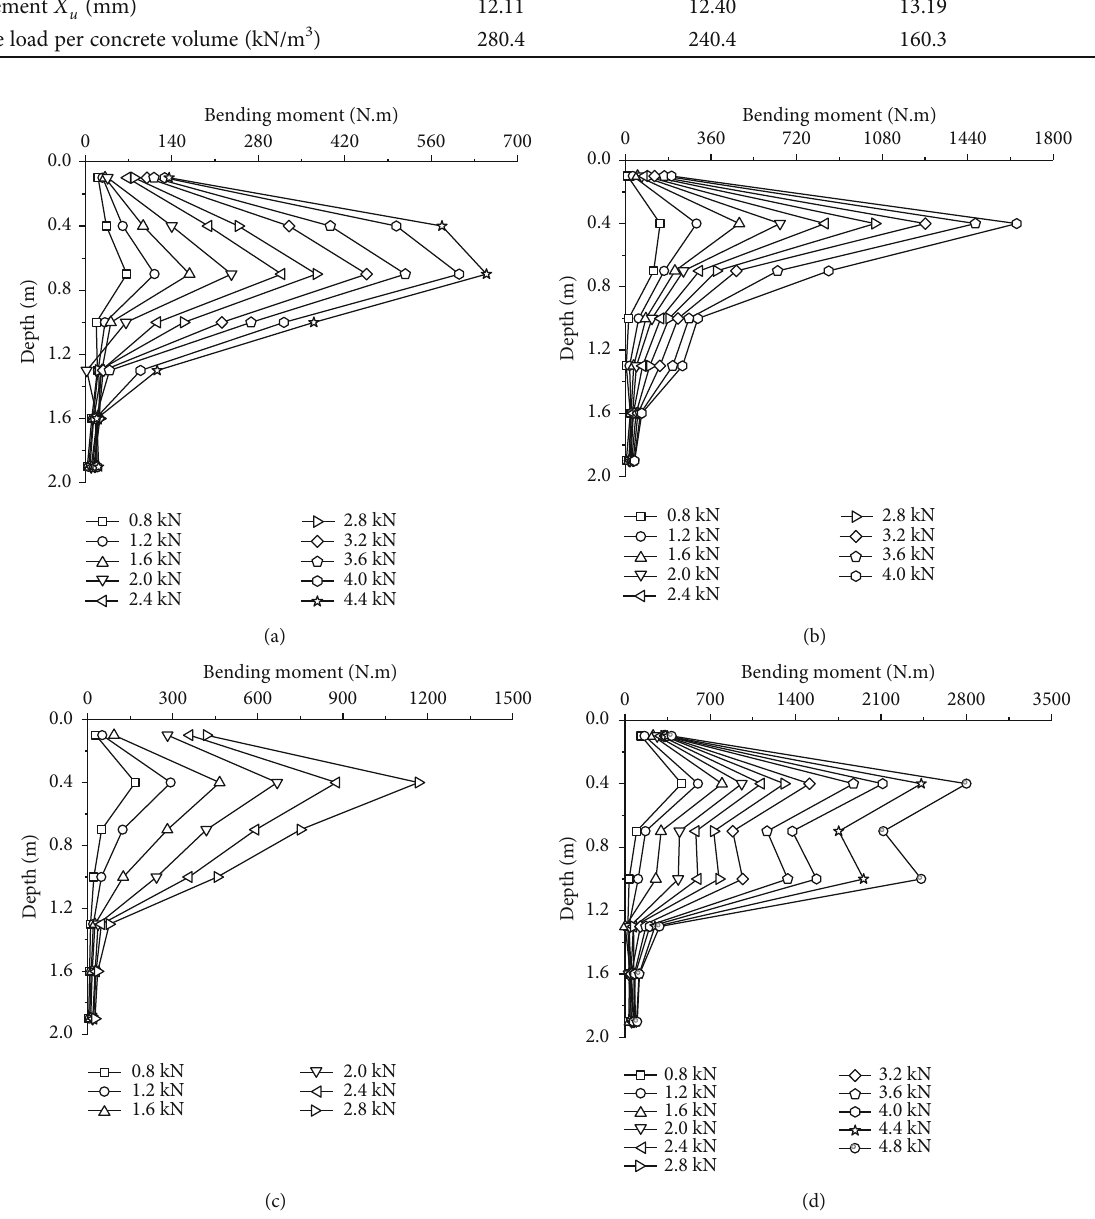
Figure 11: Bending moment along the pile: (a) Y